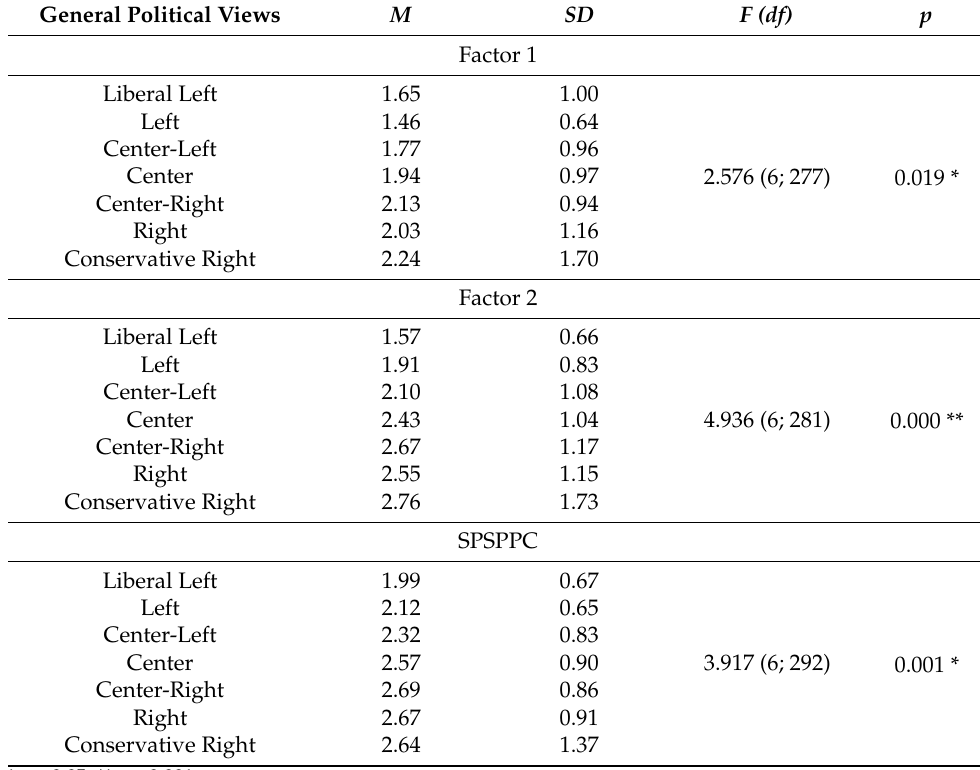
Table 5. Sexual prejudice levels by general political views.